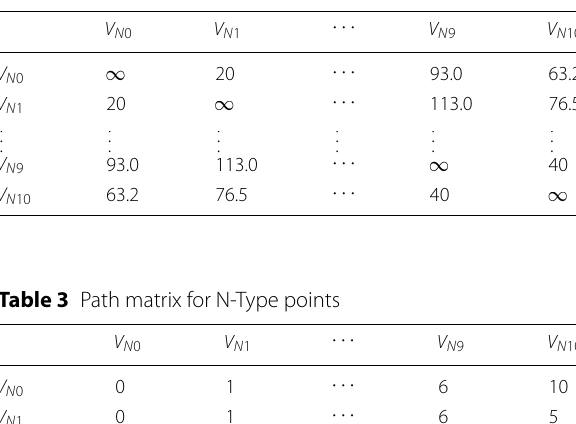
Table 2 Distance matrix for N-Type points